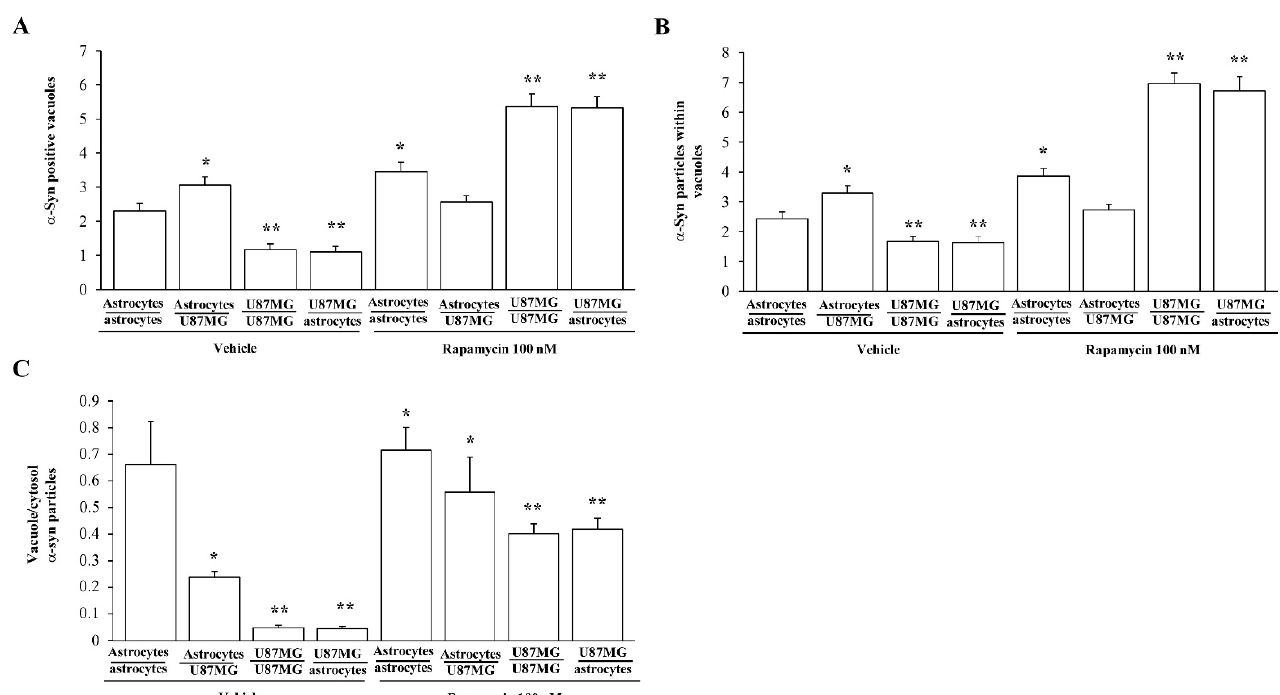
Figure 18. Ultrastructural stoichiometry of α -syn compartmentalization in co-cultures of astrocytes and GBM cells. The amount of α -syn positive vacuoles is reported in ( A ), while the mean number of α -syn immuno-gold particles within each vacuole is reported in ( B ). The ratio of α -syn immuno-gold particles within vacuoles vs. cytosol is reported in ( C ). These data are obtained from astrocytes co-cultured with astrocytes, astrocytes co-cultured with GBM cells, GBM cells co-cultured with GBM cells, and GBM cells co-cultured with astrocytes, both in baseline conditions and following rapamycin. Data are given as the mean ± S.E.M. from N = 30 cells per each experimental group. * p < 0.05 compared with astrocytes co-cultured with astrocytes; ** p < 0.05 compared with astrocytes co-cultured with GBM cells.